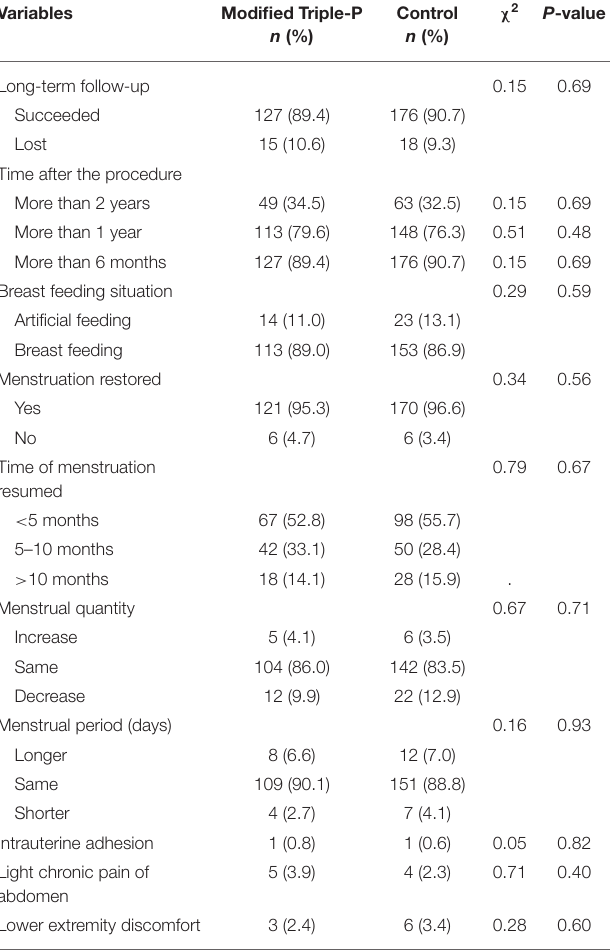
TABLE 4 | Comparation of long-term follow-up data of the patients with placenta increta/percreta treated by two different procedures.